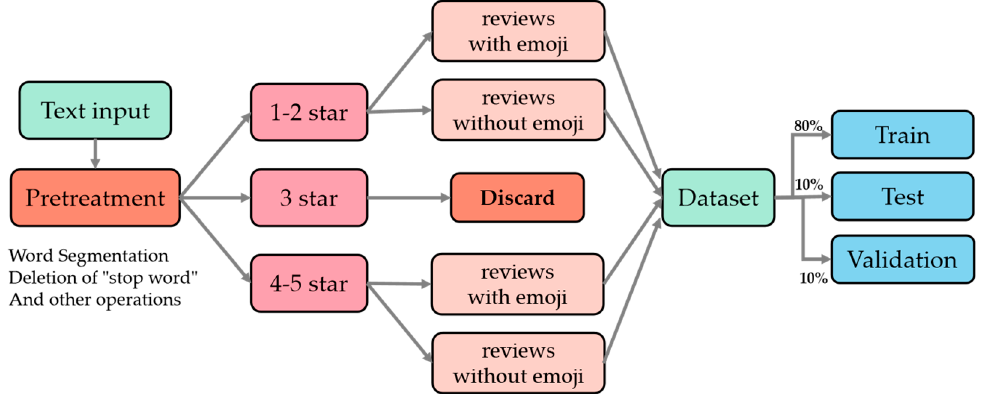
Figure 7. Data preprocessing flow chart. After the text was input, it was preprocessed to classify 1–2 stars as poor ratings and 4–5 stars as good ratings. A rating of 3 stars was a medium rating, which was not used in this paper [29]. The pre-processing process loaded deactivated word lists and removed meaningless words, punctuation, special symbols, etc. Finally, the training set, test set, and validation set were divided according to the ratio of 8:1:1.